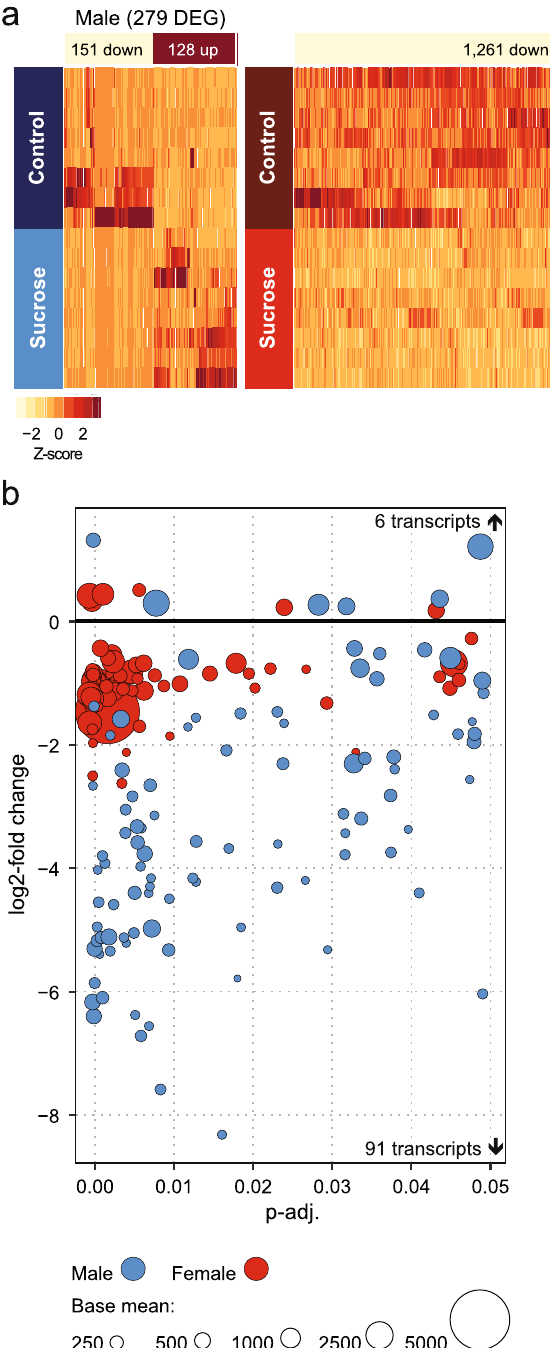
c Top 25 gene sets enriched according to the Hallmark database. NES normalized enrichment score, M male, F female, Add additive effect of sex on the effect of sucrose intake, Int. sex sucrose interaction effect, MC Male Control, MS Male Sucrose, FC Female Control, FS Female Sucrose. Relative transcript expression, including Log2 fold change and adjusted p -values are available in Supplementary File2,GeneSetEnrichmentAnalysesareavailableinSupplementaryFile4,andraw data are available from the NCBI Gene Expression Omnibus, accession number